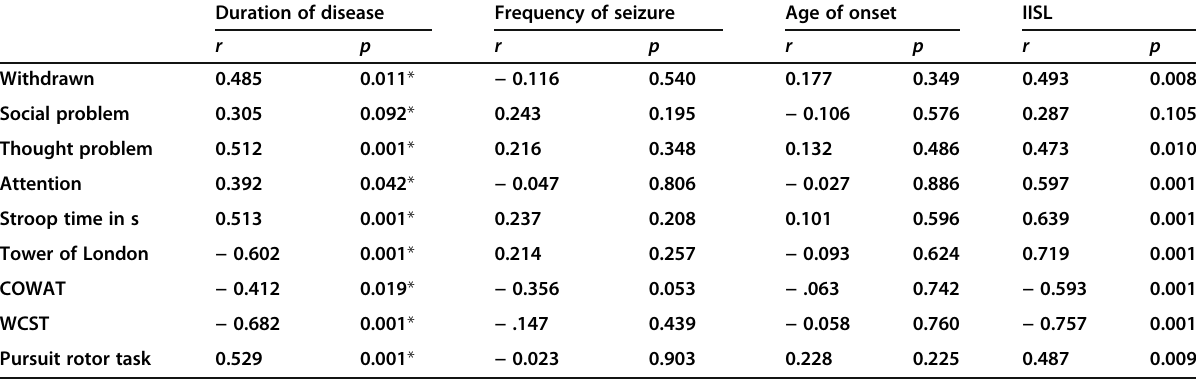
Table 3 Correlation between epilepsy-related factors with cognitive and psychiatric abnormalities Duration of disease Frequency of seizure Age of